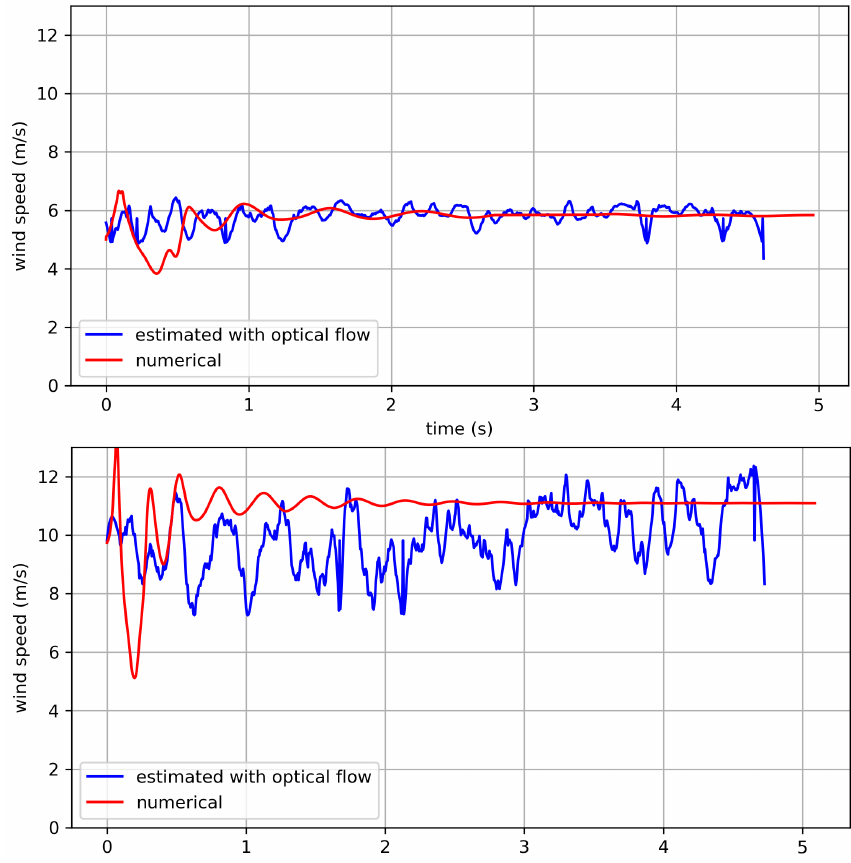
Figure 19. Numerical and experimental (video postprocessing) time history of the wind speed in the observed position for the 5 m/s (upper) and 10 m/s (lower)